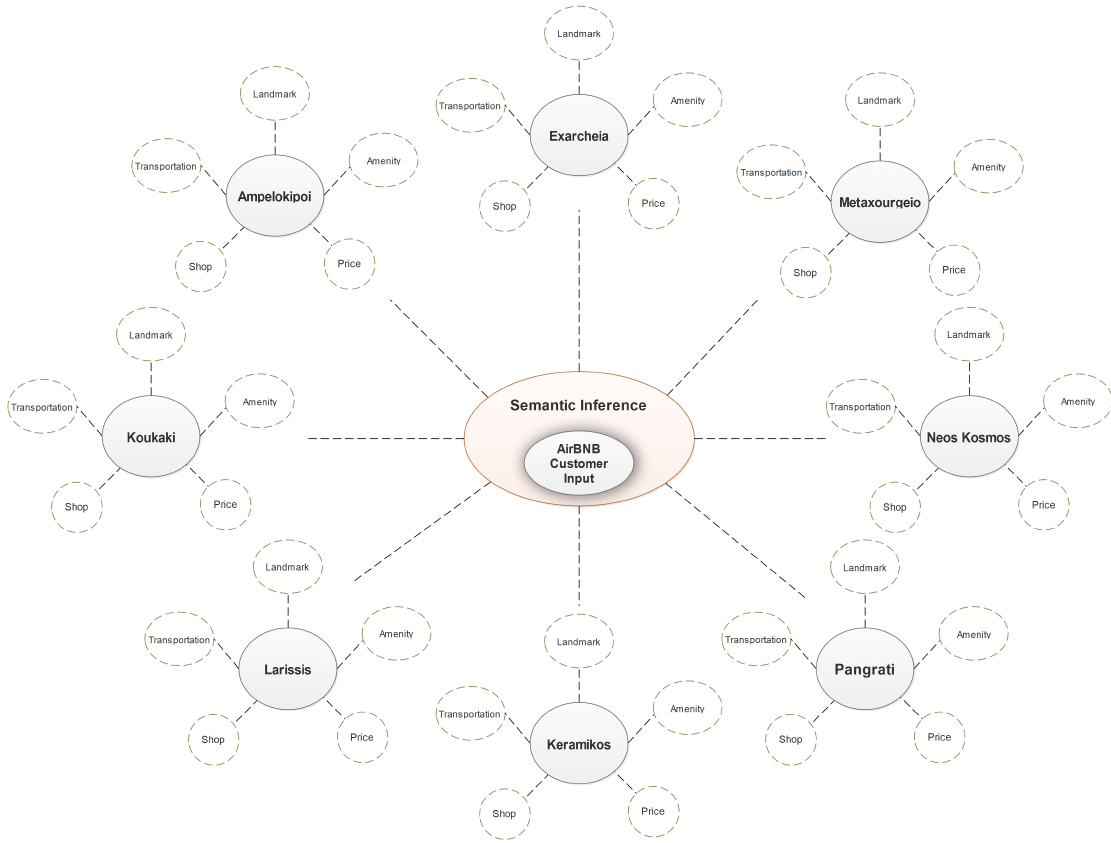
Figure 5. Schematic representation of the proposed